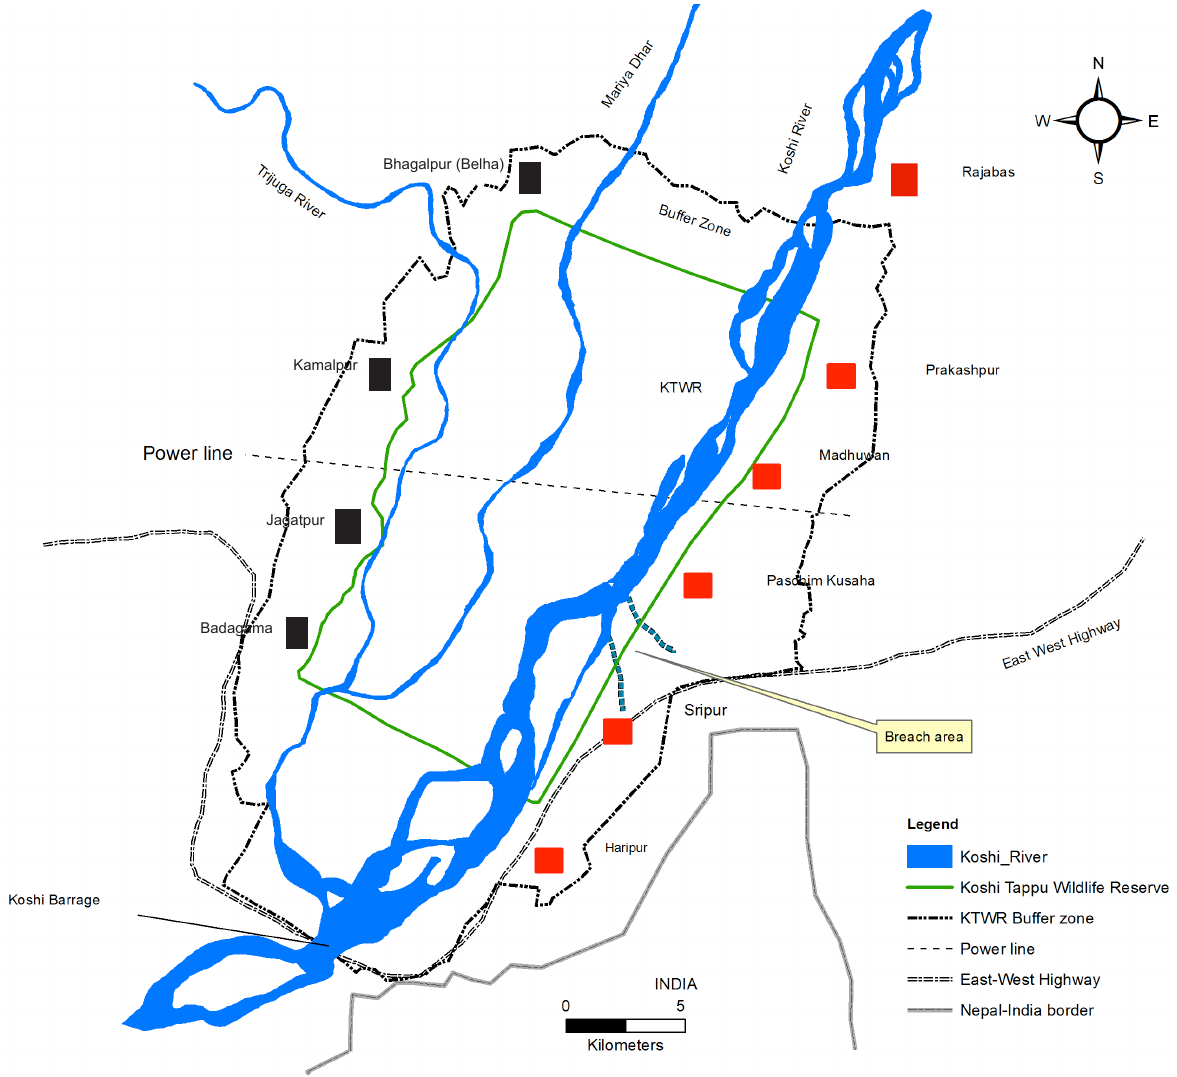
Figure 1. Study site showing Koshi Tappu Wildlife Reserve and its Buffer